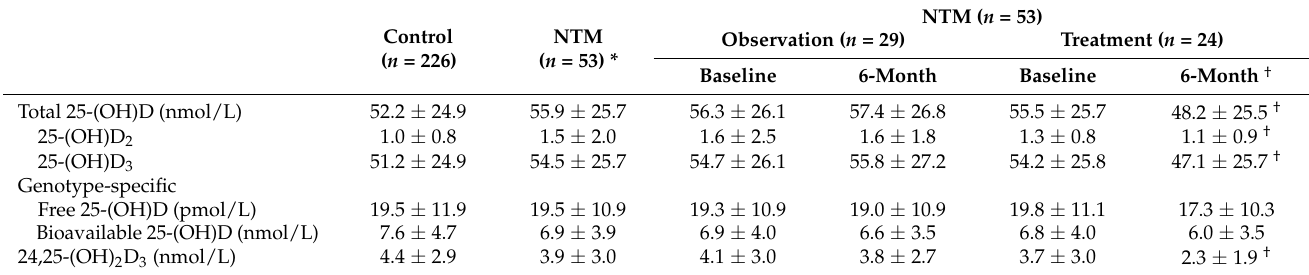
Table 3. Baseline and 6-month follow-up of total, bioavailable, and free 25-(OH)D levels in study subjects.